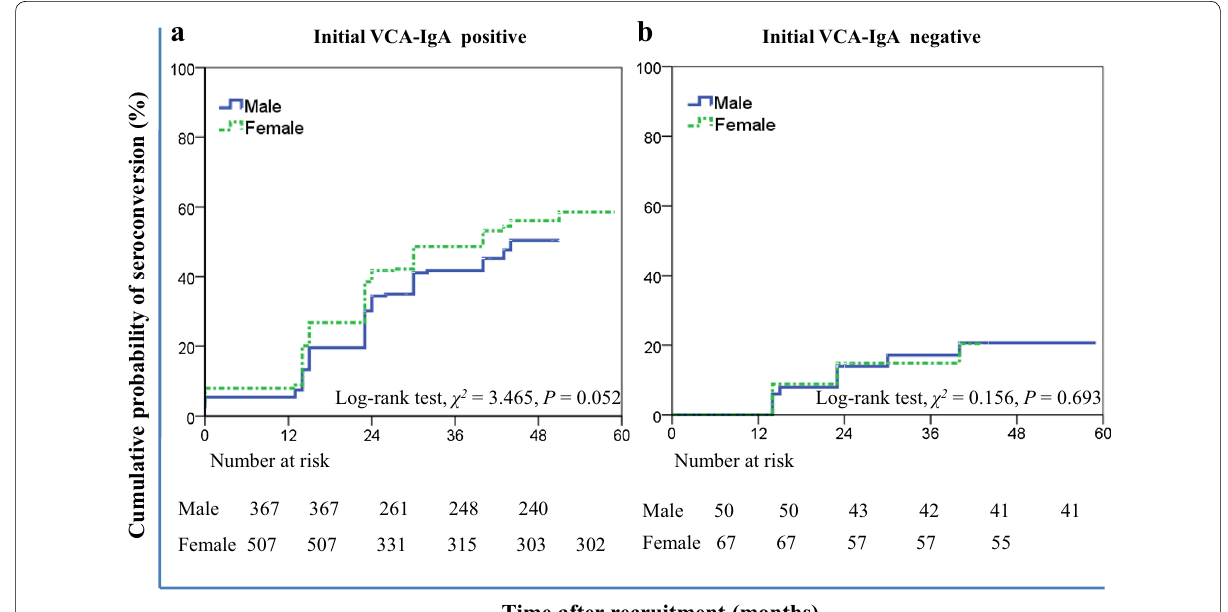
Fig. 2 Cumulative probability for the male and female participants with an initial VCA‑IgA‑positive or ‑negative status who met the high risk criteria in the first 5‑year follow‑up. a Cumulative probabilities of seroconversion for meeting any of the high risk criteria in the participants with an initial VCA‑IgA‑positive status were not different between males and females; b cumulative probabilities of seroconversion for meeting any of the high risk criteria in the participants with an initial VCA‑IgA‑negative status were similar for males and